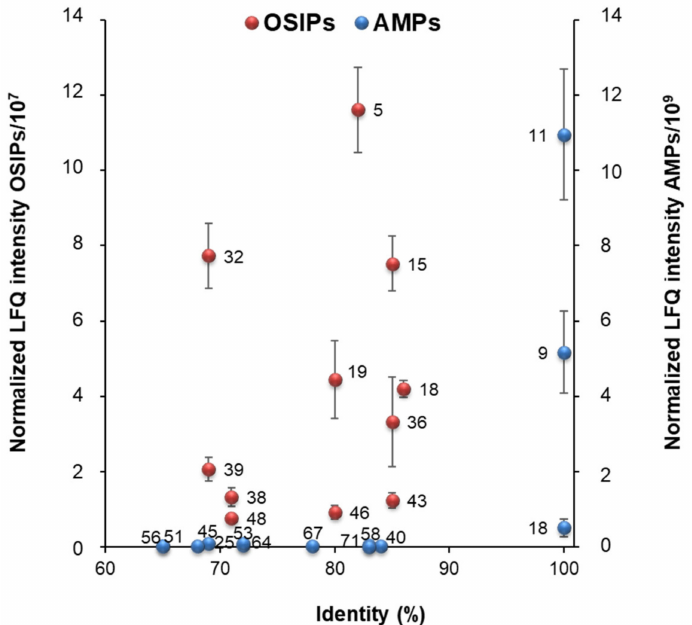
Figure 4. Scatterplot showing the relationship between the sequence similarity of the identified proteins (expressed as percent identity) with the original plant-derived bioactive proteins ( x -axis) and their normalized LFQ intensities ( y -axis). Averages of the normalized LFQ intensities obtained for the four analyzed quinoa grains and errors bars for the standard deviation are depicted. A value of 65% identity was set as threshold to increase the significance of the interpretation (13 out of the 71 AMPs, 11 out of the 48 OSIPs, and none of the STPIs were included in the